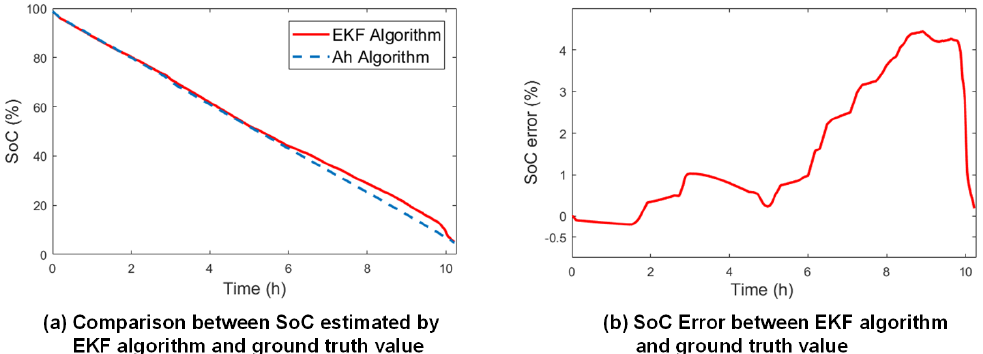
Figure 2. Comparison between SoC estimated by EKF algorithm and the ground truth (SoC calculated by coulomb counting method): ( a ) Comparison between SoC estimated by EKF and the ground truth; ( b ) SoC error between EKF and the ground